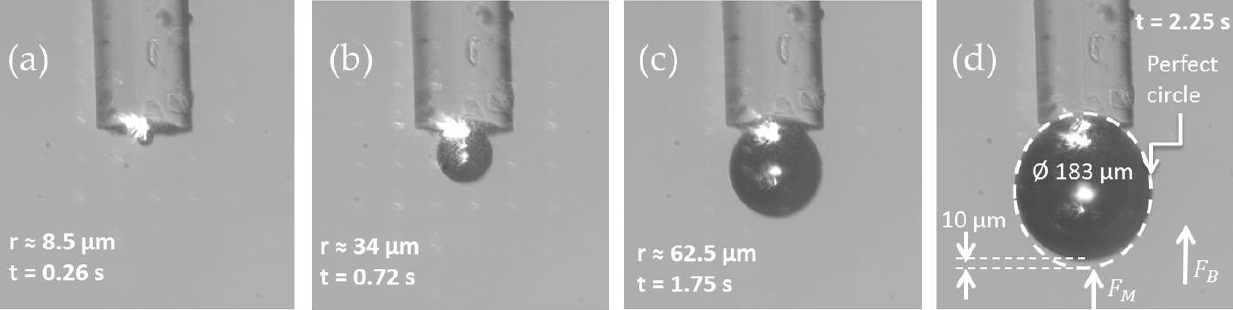
Figure 4. Snapshots show the growth of a microbubble onto optical fiber end over time, under a laser power of 12 mW. Microbubble in ( a ) t = 0.26 s, ( b ) t = 0.72 s, ( c ) t = 1.75 s, and ( d ) t = 2.25 s.